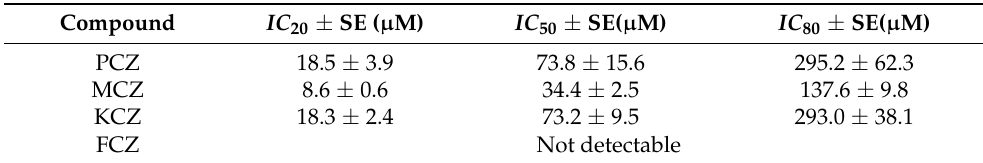
Table 1. IC 20 , IC 50 , and IC 80 of the tested azoles. The non-linear fitting of the dose-response curve of the drugs alone was used to estimate the inhibitory concentration at three different levels of efficacy: IC 20 , IC 50 , and IC 80 , which respectively identify the 20%, 50%, and 80% fractions of cells affected by the drugs ( Fa ) at 48 h of exposure. Values indicate the mean ± SE.